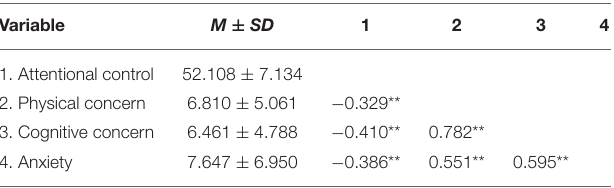
TABLE 2 | Correlation matrix of attentional control, physical concern, cognitive concern, and anxiety ( n = 464). Variable